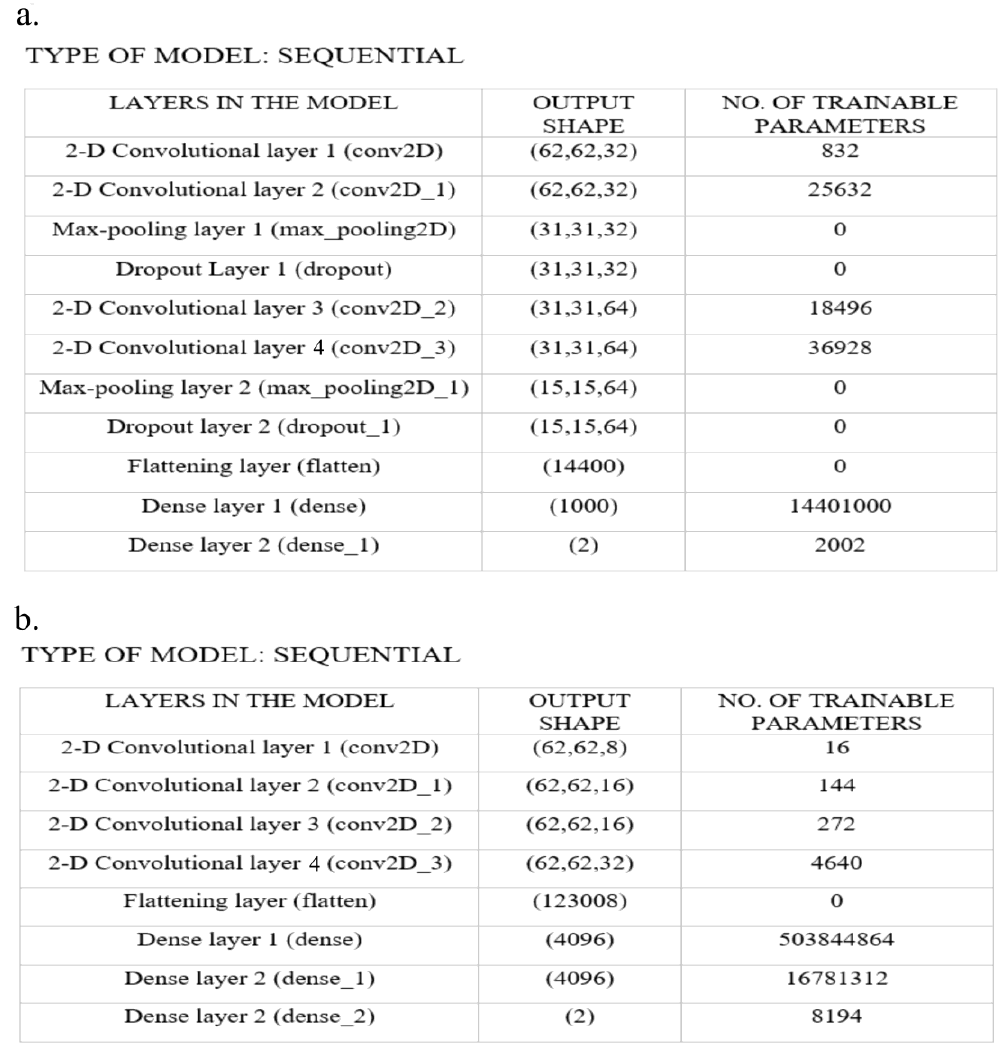
Figure 2. Deep neural network architectures ( a ) 11-layer model designed to classify when connectivity matrix was considered as an image and, ( b ) model with 8 layers where convolutional layers are having kernel size of 1x1 to classify LGG and HGG when their connectivity matrix was considered as a matrix. The model layer details were obtained from TensorFlow.